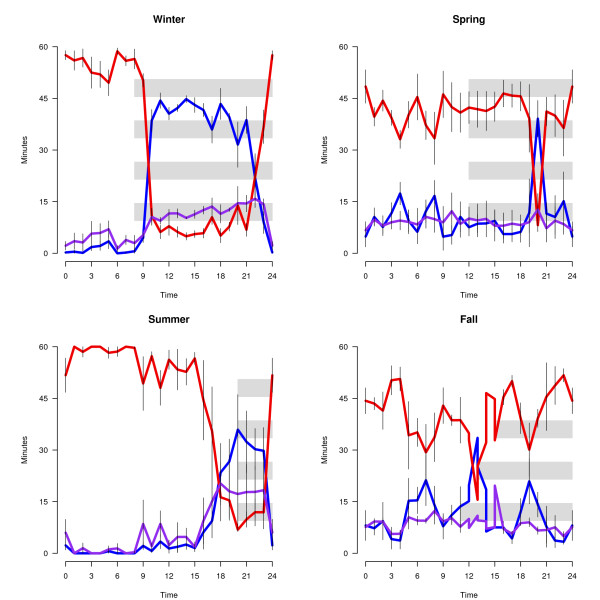
Time course of each vigilance state, wake (red), sleep (purple) and drowsiness (purple), in each of the four seasons. Values plotted as mean number of minutes (± SEM,) of each state in 1-hour intervals. Time 0 represents lights on. Note that the fall birds were not scored on the same day and so each bar indicates the dark period for one of the three birds.